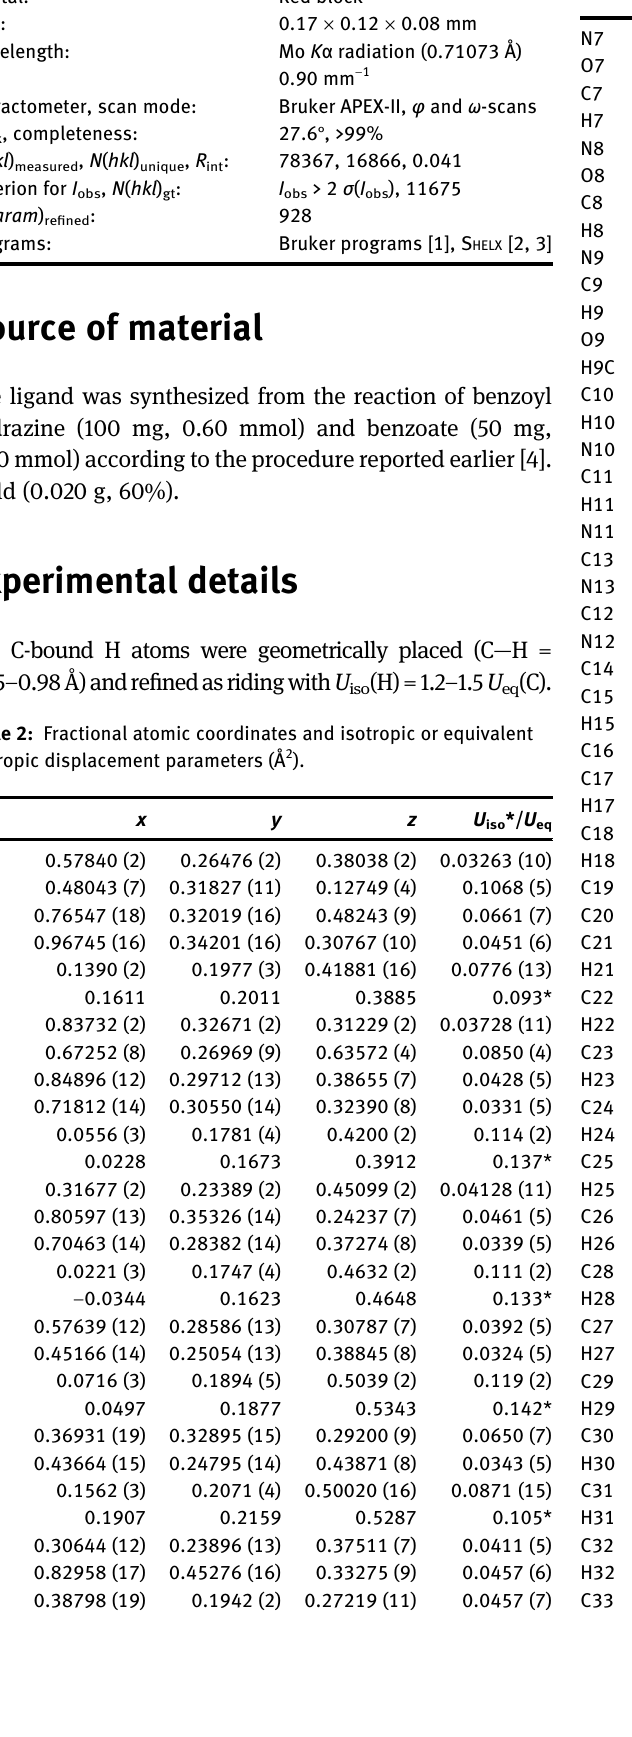
Table  : Data collection and handling. Crystal: